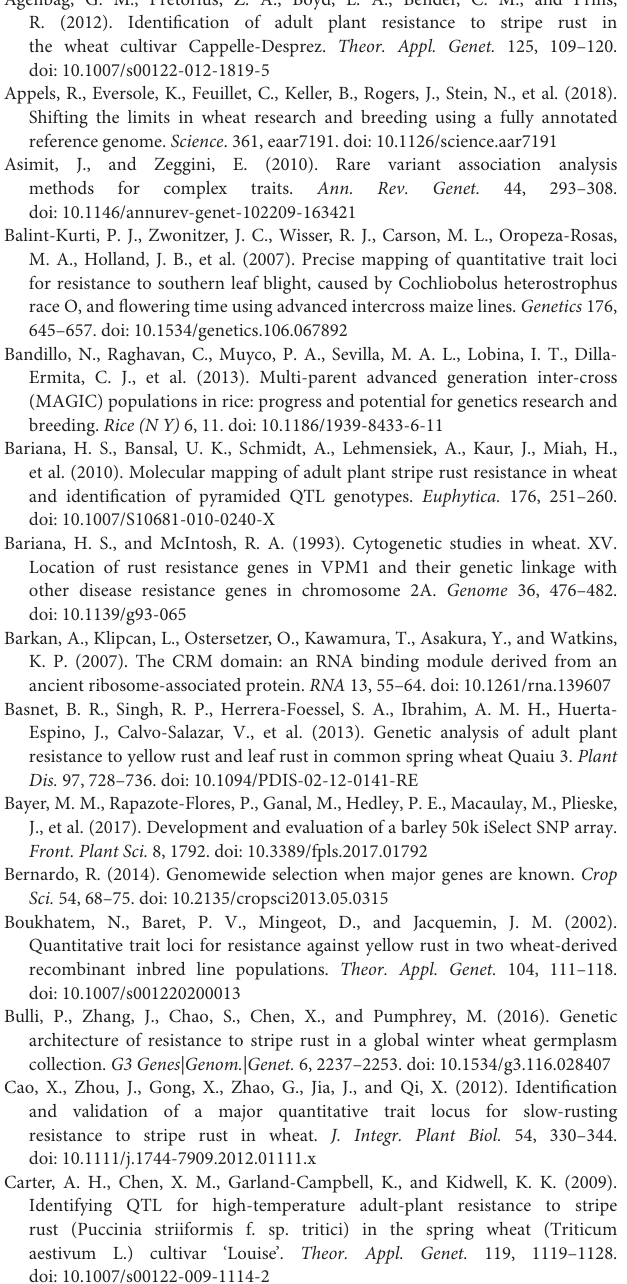
Supplementary Table 2 | Complete information of the quantitative trait loci (QTL) for stripe rust resistance in BMW population, evaluated in field trials (AO) and seedling test (IT and Pi).